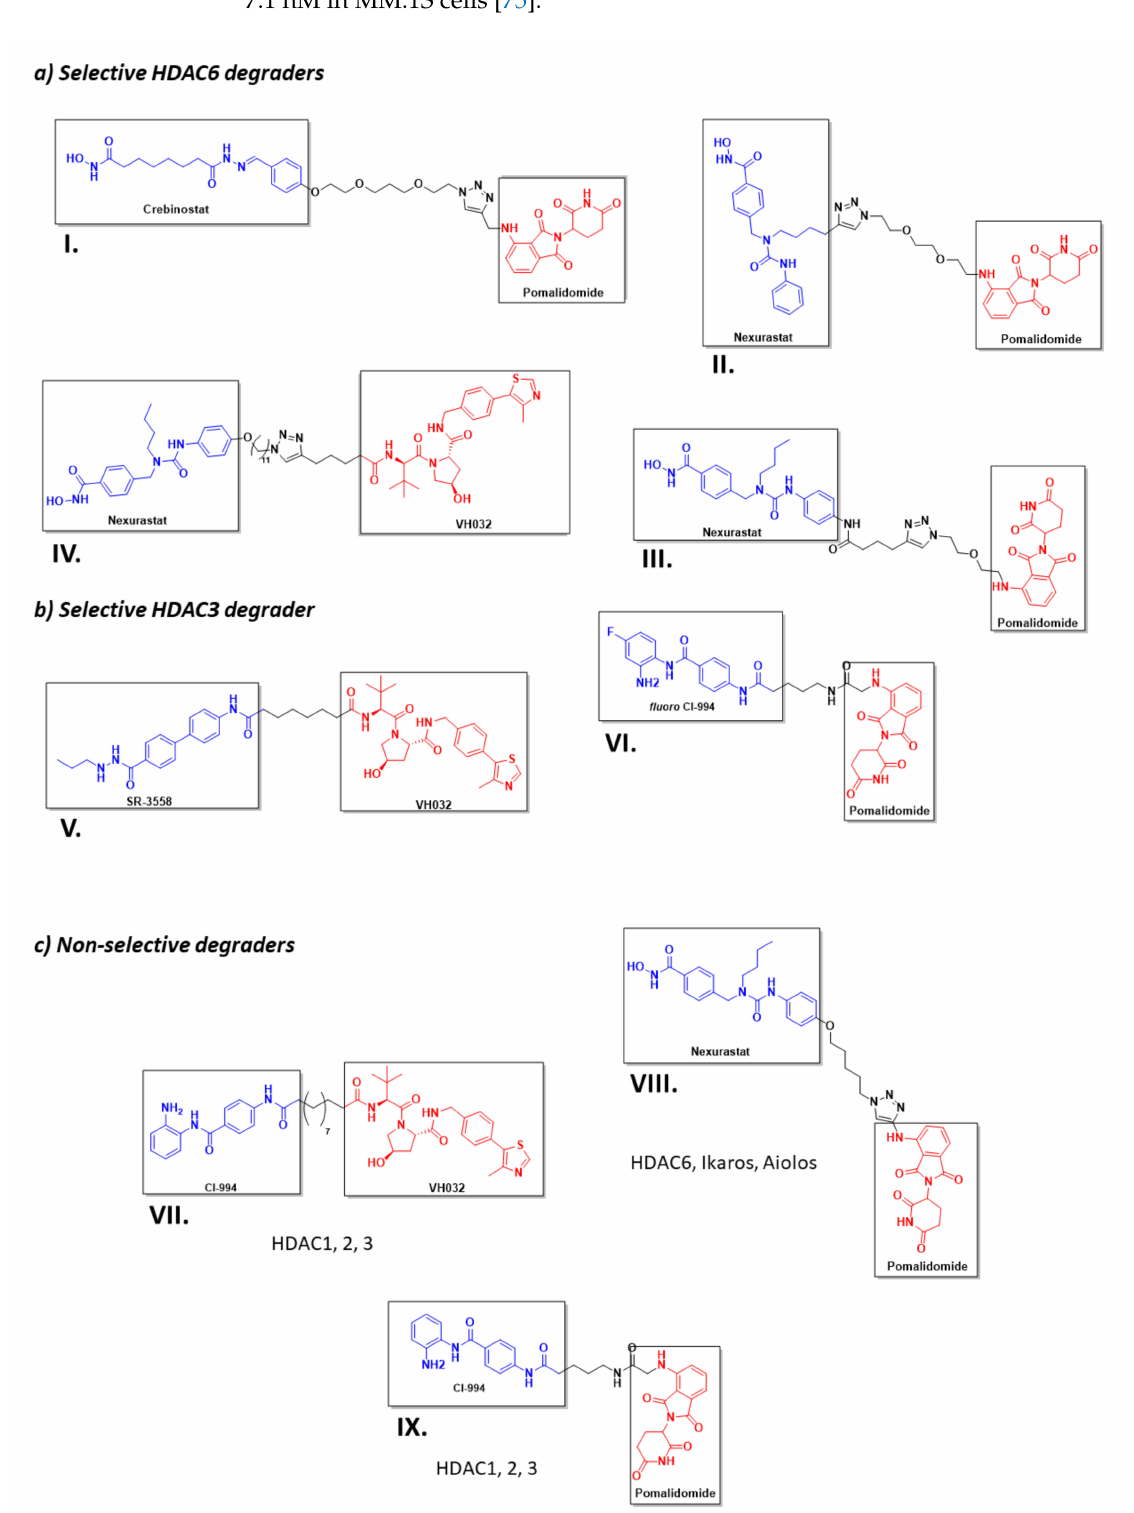
Figure 13. 2D representation of the structures of the known HDAC-directed PROTACs [60,61,166–170,172] adapted from Smalley J. P. et al.